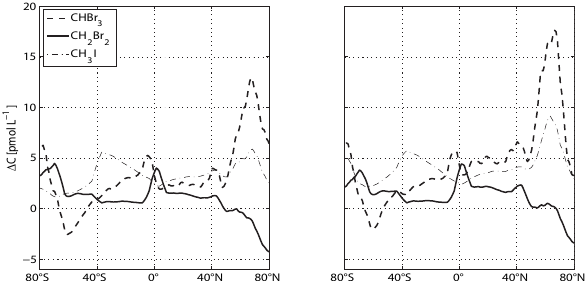
Fig. 6. Zonal mean concentration gradients for bromoform (dashed line), dibromomethane (solid line) and methyl iodide (dash-dotted line) in pmolL − 1 , calculated with RF (left side) and OLS (right side)